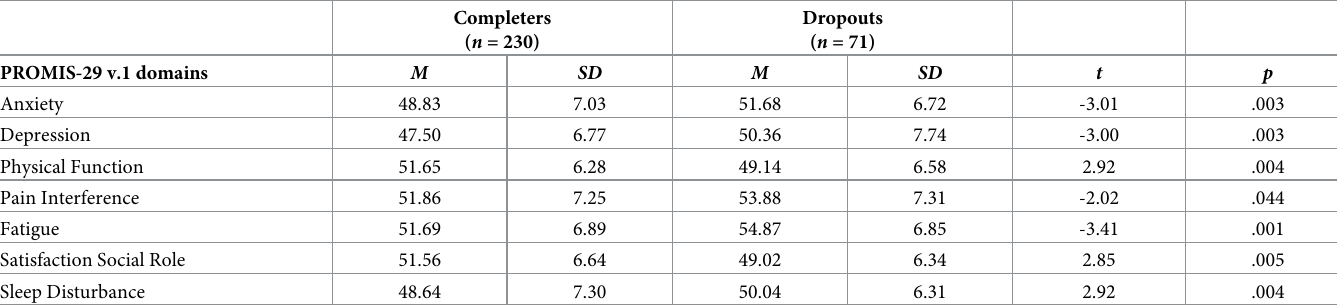
Table 2. Comparison of baseline PROMIS-29 v 1. scores for women who completed the study compared to women who dropped out.